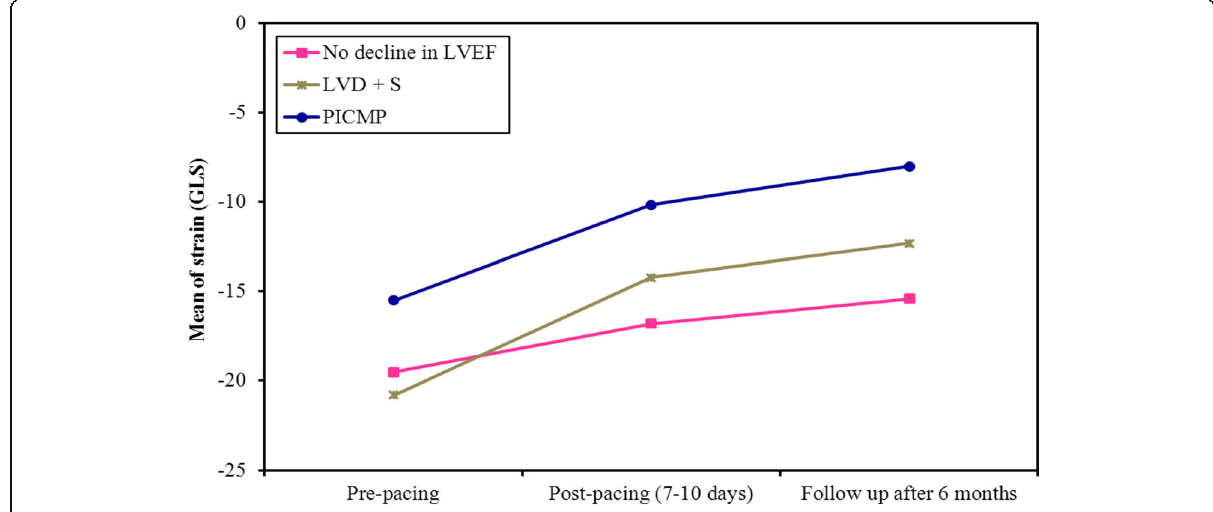
Fig. 2 Comparison between the three studied groups according to changes in Global Longitudinal Strain (GLS) in each group